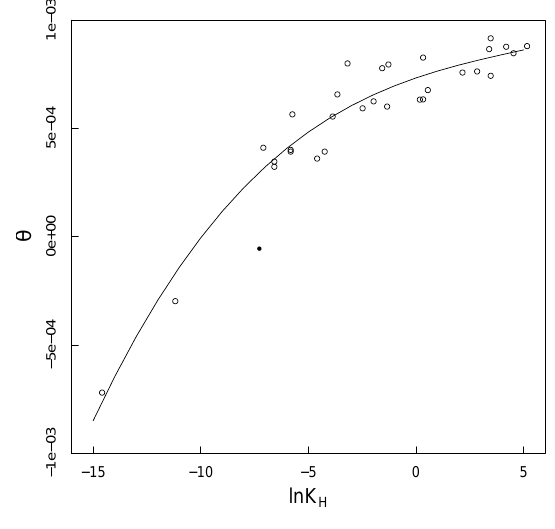
Fig. 6. Regression of the natural logarithm of the Henry’s law con- stant at S = 0 and T = 25 ◦ C with the molar volume scaling factor, θ for the gases listed in Table 1, with the exception of the data of Sing et al. (1999) (marked as solid point on chart) and that of Elliott and Rowland (1993) (see main text for